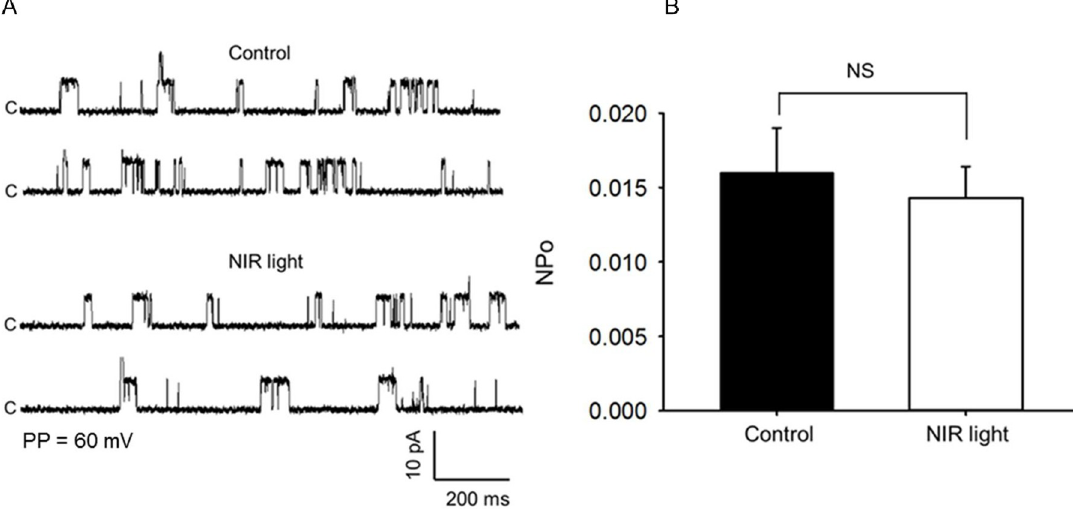
Fig 5. R/NIR does not directly activate the BK Ca channel. Exposure to NIR light has no significant effect (NS, n = 6 animals/group 1–2 independent replicates per animal) on the opening frequency (A) and NPo (B) of the 273 pS BK Ca single channel current recorded from excised inside-out patches of wild type mice isolated femoral arterial smooth muscle